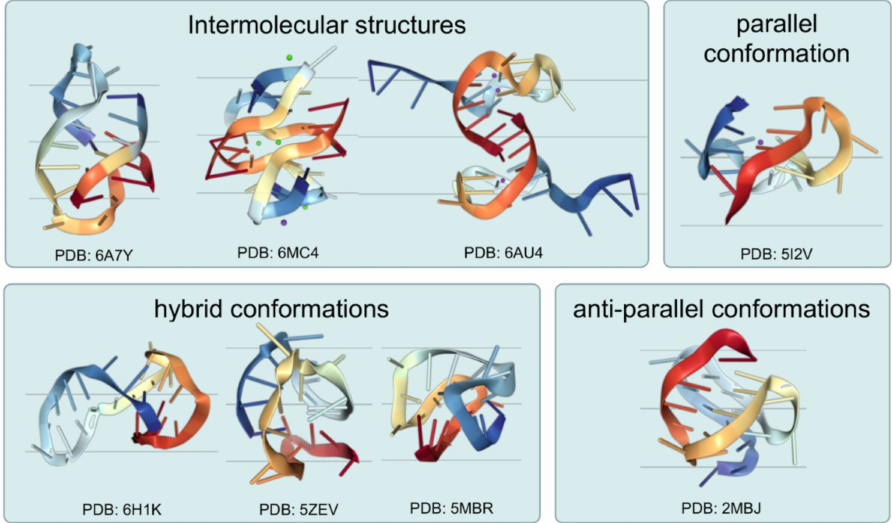
Figure 2. Structural diversity of G-quadruplexes. G-quadruplexes structures may form intramolecular G-quadruplex or intermolecular G-quadruplex structures (PDB: 6A7Y [46], 6MC4 [47], and 6AU4 [48]). Moreover, the G-quadruplex structures divide into different conformations, including parallel (PDB: 5I2V [49]), antiparallel (PDB: 2MBJ [50]), hybrid (PDB: 6H1K [51], 5ZEV [52], and 5MBR [53])